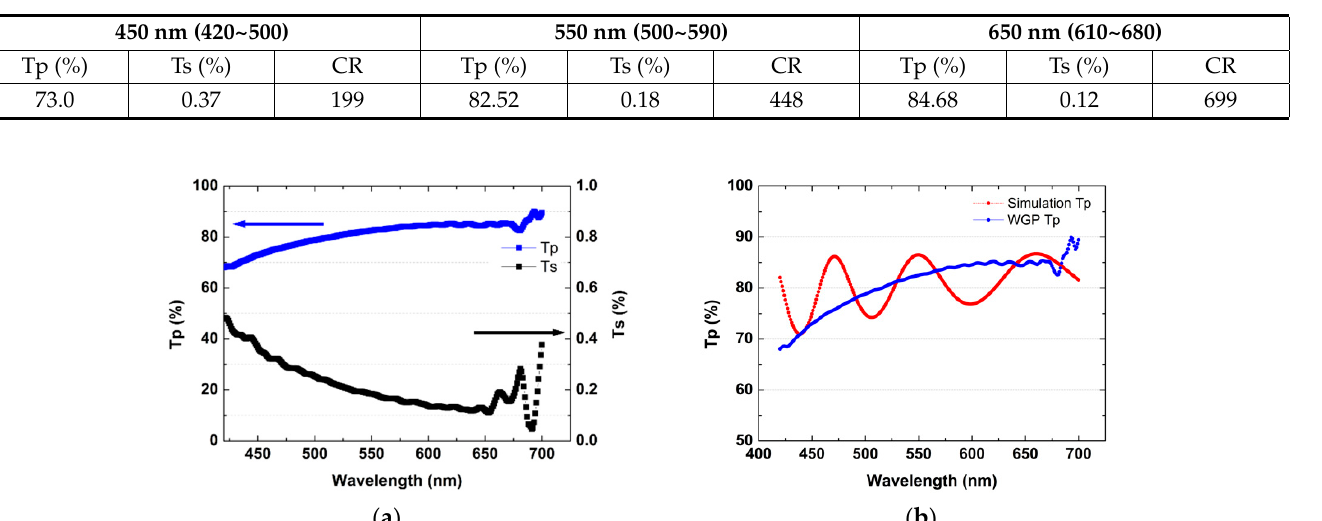
Table 1. Transmittance data of WGP in the visible light region RGB. The Contrast Ratio (CR) is the ration of Tp and Ts (Tp/Ts).